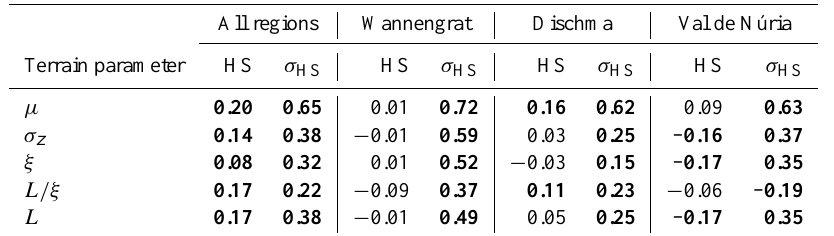
Table 1. Pearson correlation coefficients r for mean snow depth HS and standard deviation of snow depth σ HS with terrain parameters for pooled data of all three catchments as well as for each catchment separately. Gaussian covariance parameters σ ( σ z ) and ξ are obtained as described in Sect. 3.2. For mean slope µ , see Eq. (1). Values in bold indicate statistically significant correlations ( p values < 0 . 05). All regions